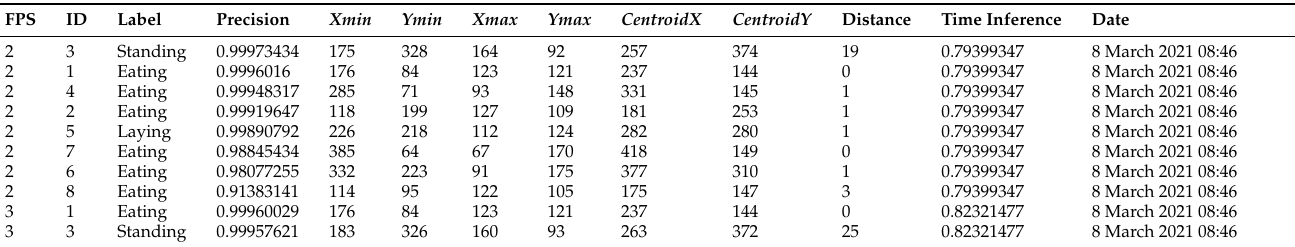
Table 2. Sample of metrics stored in object detection.